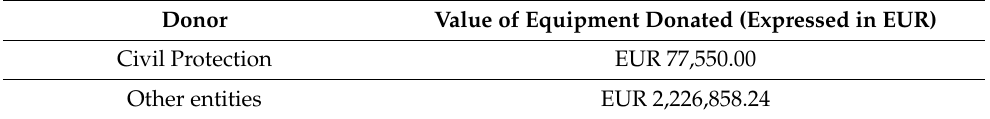
Table 11. Amount of equipment donations received by Spedali Civili Hospital in Brescia between